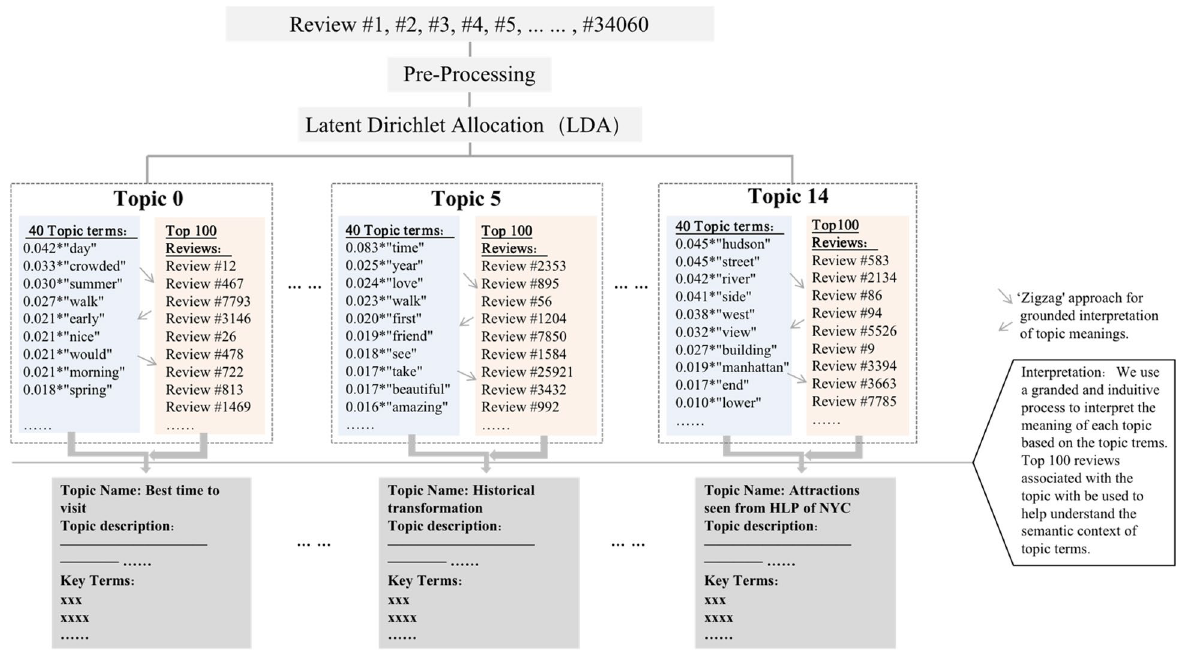
Fig. 5 Flowchart of our mixed method including LDA modeling and qualitative